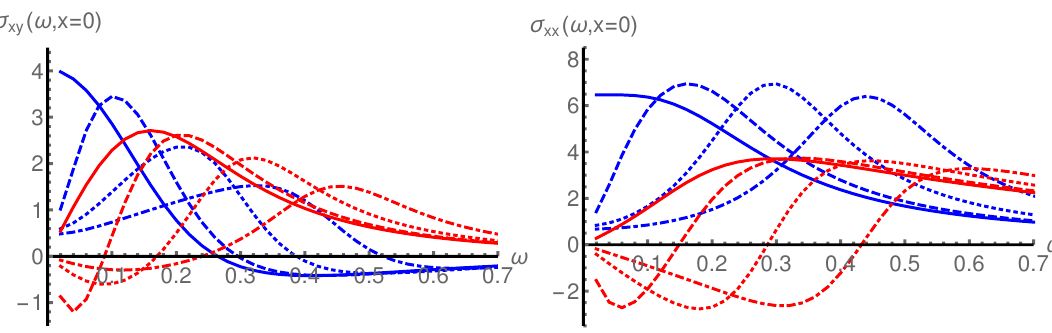
Figure 13 . The pinning effect due to the magnetic lattice on the components of the conductivity that do not feature delta peaks, at b = 0 . 5 and x = 0 . The blue (red) curves are real (imaginary) parts, and the solid, dashed, dotted, and dot-dashed curves are for α b = 0 , 0 . 1 , 0 . 25 , and 0 . 5 , respectively. Left: the behavior of σ xy at x = 0 . Right: the behavior of σ xx at x = 0 .